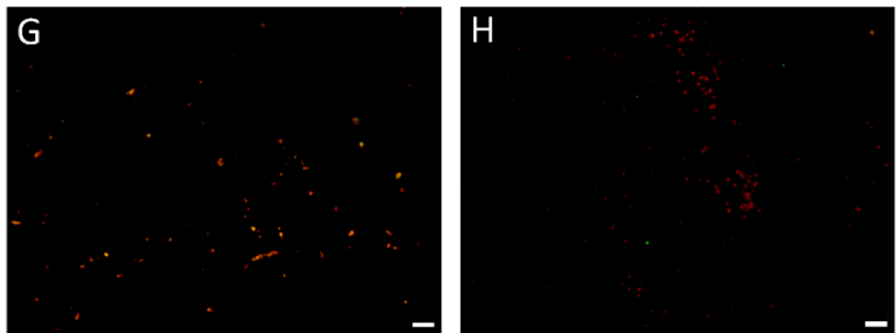
Figure 5. The fluorescence microscopy of H. pylori cells during the incubation with 3-Bromopyruvate (3-BP): The representative microscopic images of H. pylori cells during the incubation with the MIC of 3-BP after ( A ) 0 h, ( B ) 1 h, ( C ) 2 h, ( D ) 4 h, ( E ) 6 h, ( F ) 8 h, and ( G ) 24 h. The negative control consisted of bacterial cells ( H ) after a 1 h treatment with 70% ethanol. The green cells indicate live bacteria, whereas the red/orange cells indicate damaged, dead bacteria. The scale bar in the fluorescence microscopy is 20 μ m.